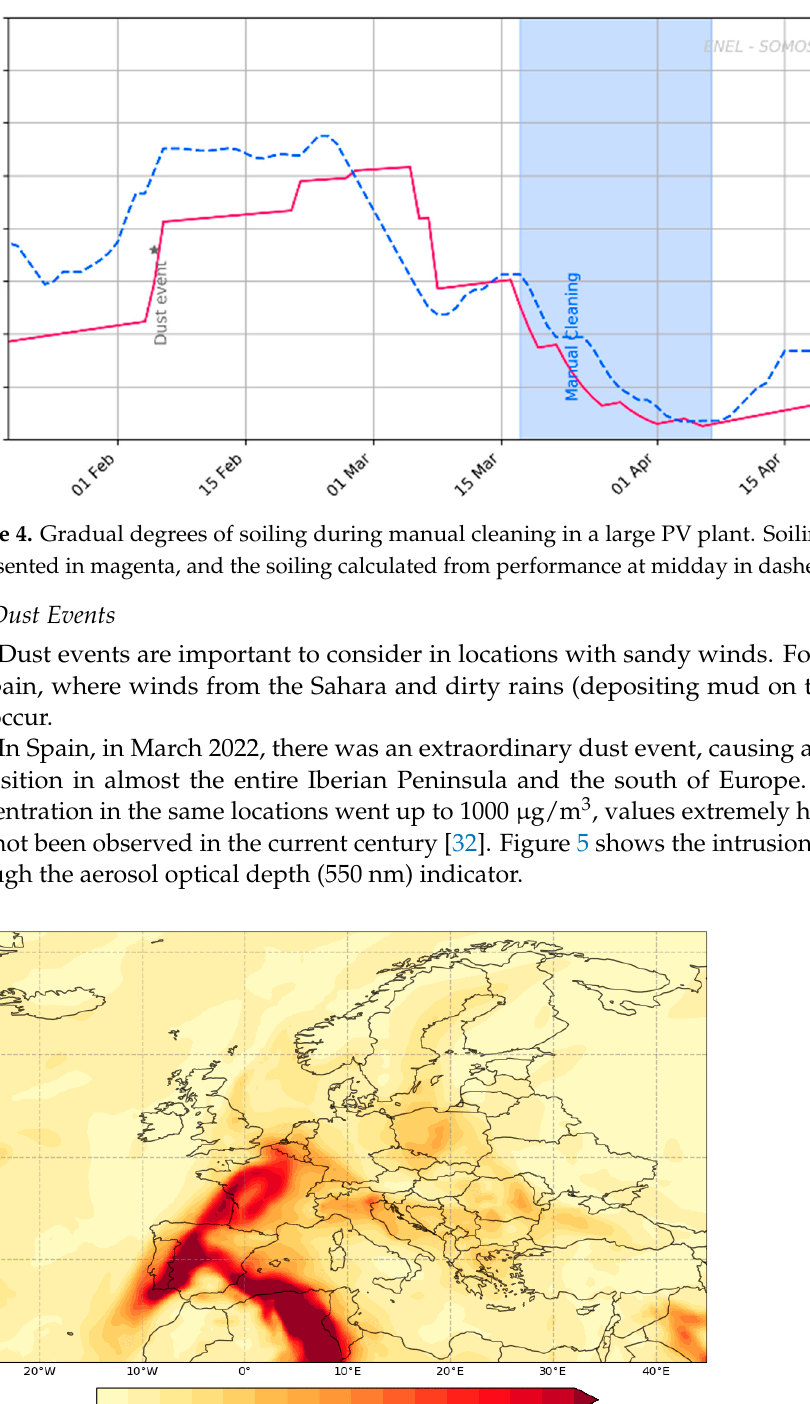
Figure 6. Upper plot: Soiling model (magenta line) and soiling sensor output (dashed blue line). Lower plot: Rainfall (mm/day) and PM10 concentration (µg/m 3 ).